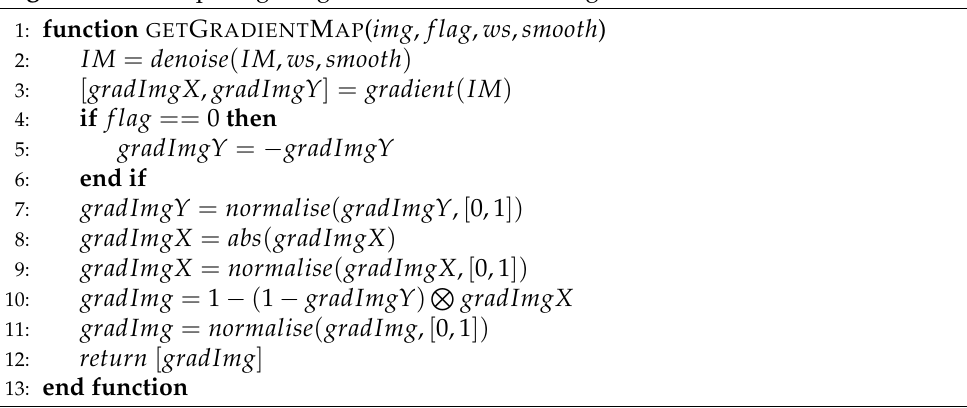
Algorithm 4 Computing the gradient of the OCT